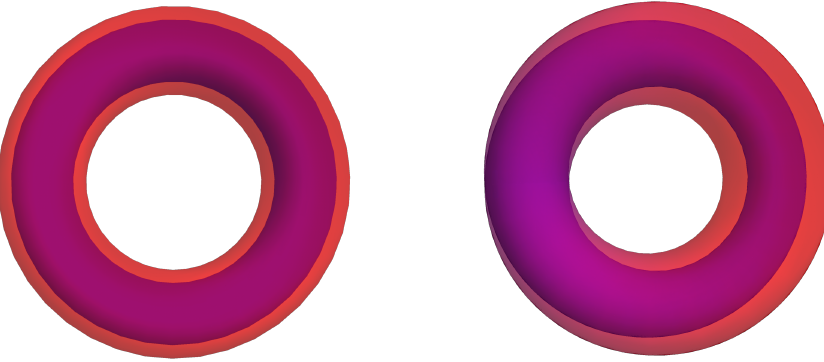
Figure 9 . The two averaged stringy geometries that condense to classical thermal AdS 3 for a degree two covering surface. In this figure, the boundaries of the inner and outer torus are identified.